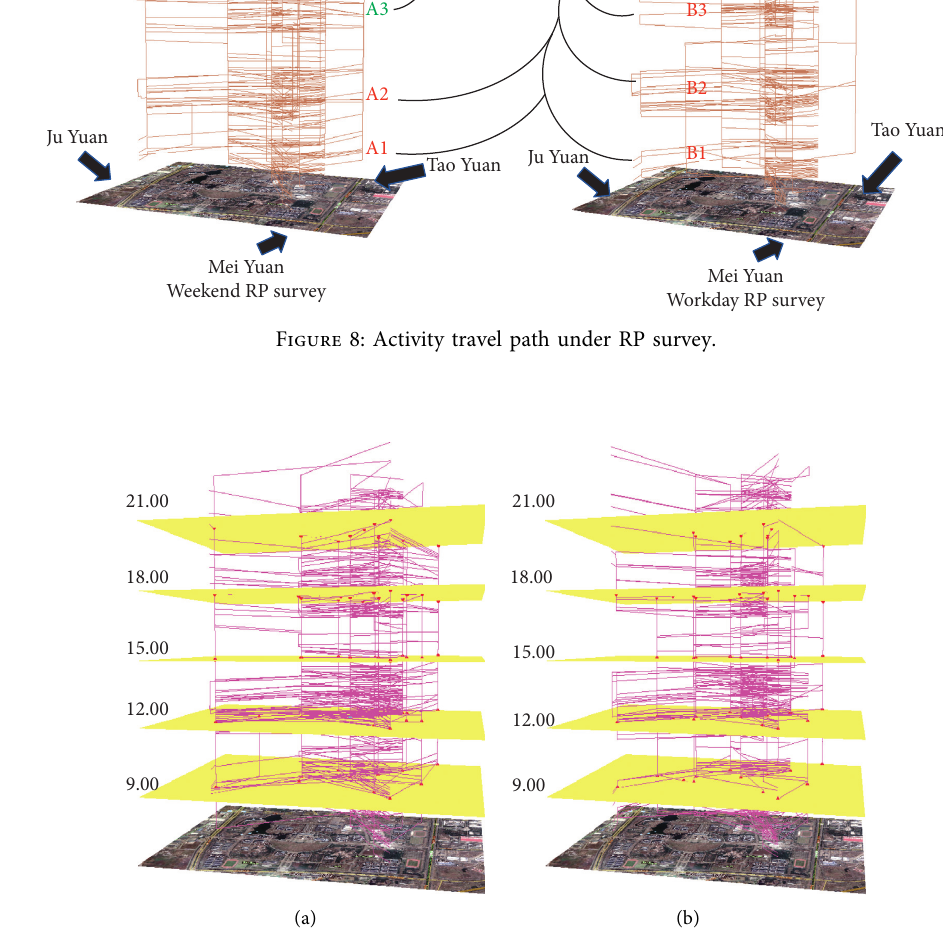
Figure 9: Distribution of activity points at different times on (a) weekends and (b)